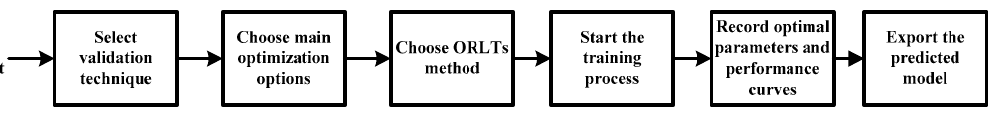
Figure 6. Training procedure of ORLTs.